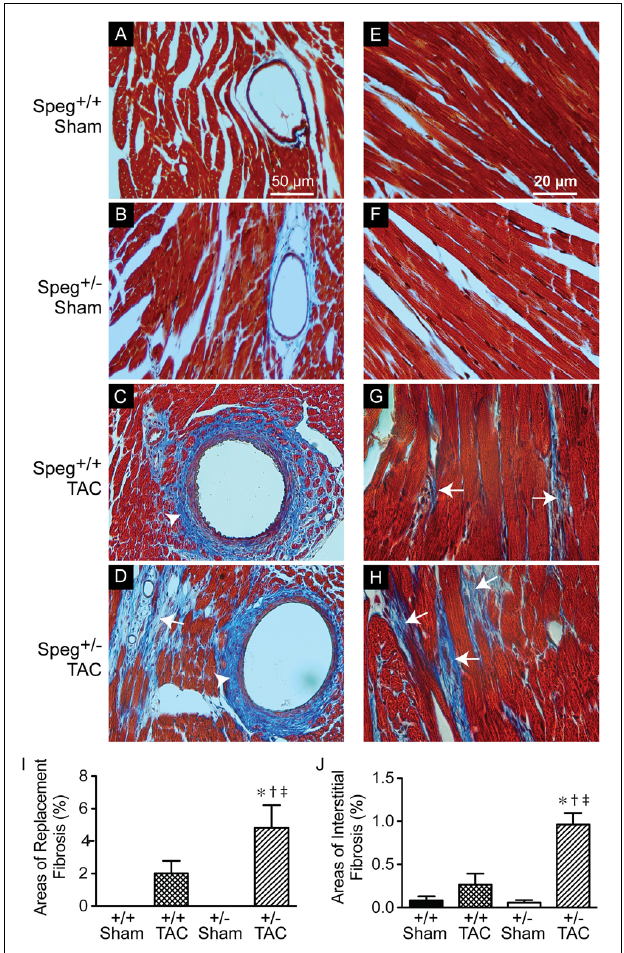
FIGURE 8 | Increased areas of focal replacement fibrosis, and interstitial fibrosis, in the hearts of Speg + / − mice post-TAC. Transverse aortic constriction (TAC) or sham surgery (sham) was performed on 8-week old Speg wild type (+/+) and heterozygous (+/–) mice. Hearts were harvested 4 weeks after TAC and histological analyses were performed. Representative images of hearts from Speg + / + (A,C,E,G) and Speg + / − (B,D,F,H) mice were stained by Masson’s Trichrome, in which collagen stains blue while the myocytes stain red. Scale bars, 50 µ m (A–D) and 20 µ m (E–H) . White arrows denote areas of focal replacement fibrosis (D) and interstitial fibrosis (G,H) . White arrowheads denote perivascular fibrosis (C,D) . Quantitation for percent area of focal replacement fibrosis (I) and interstitial fibrosis (J) from sections of the same hearts ( n = 4 hearts/group) are shown in the bar graphs. Analysis by one-way ANOVA ( P < 0.05), with significant comparisons ∗ versus sham of the same group; † versus Speg + / + TAC; ‡ versus Speg + / + sham.